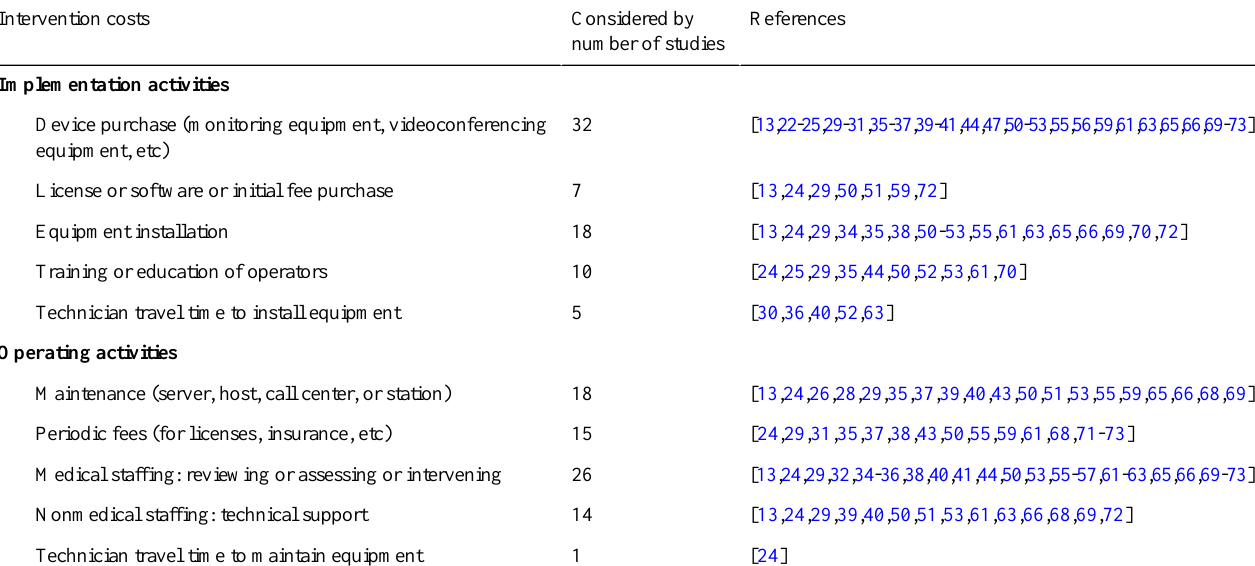
Table 1. Intervention costs of eHealth